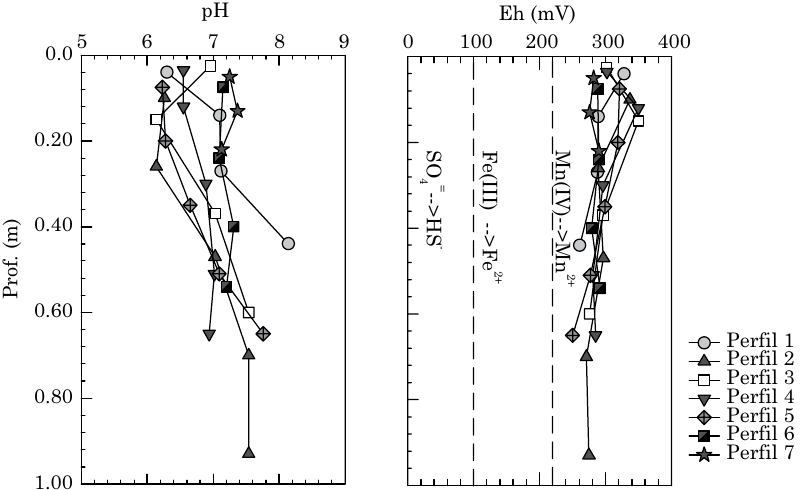
Figure 2. Distribution of pH and Eh in field in deeper layers in the mangrove soil profiles in the Subaé river basin, Santo Amaro, Bahia, Brazil.